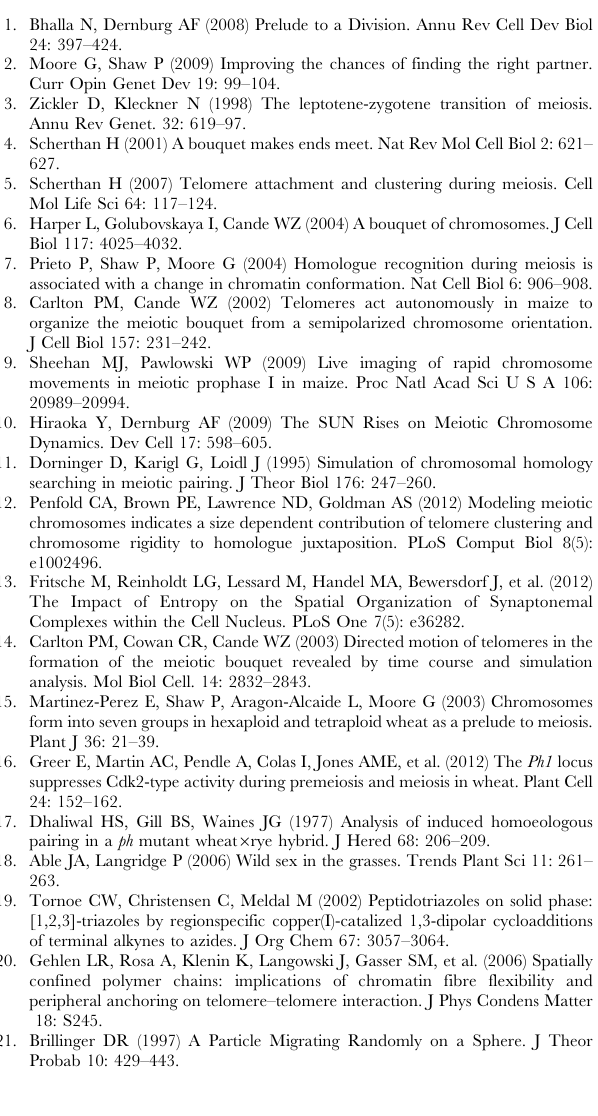
Figure S4 Average total time for bouquet formation against the diffusion constant for a constant drift speed of 8.5 6 10 2 4 m ms 2 1 . The error bars are too small to be visible. Figure S5 Behaviour in time of the average telomere cluster distance, d pairs , in the deterministic pure drift model with a randomly-orientated initial cap. Blue lines: individual examples. Red line: average over many initial